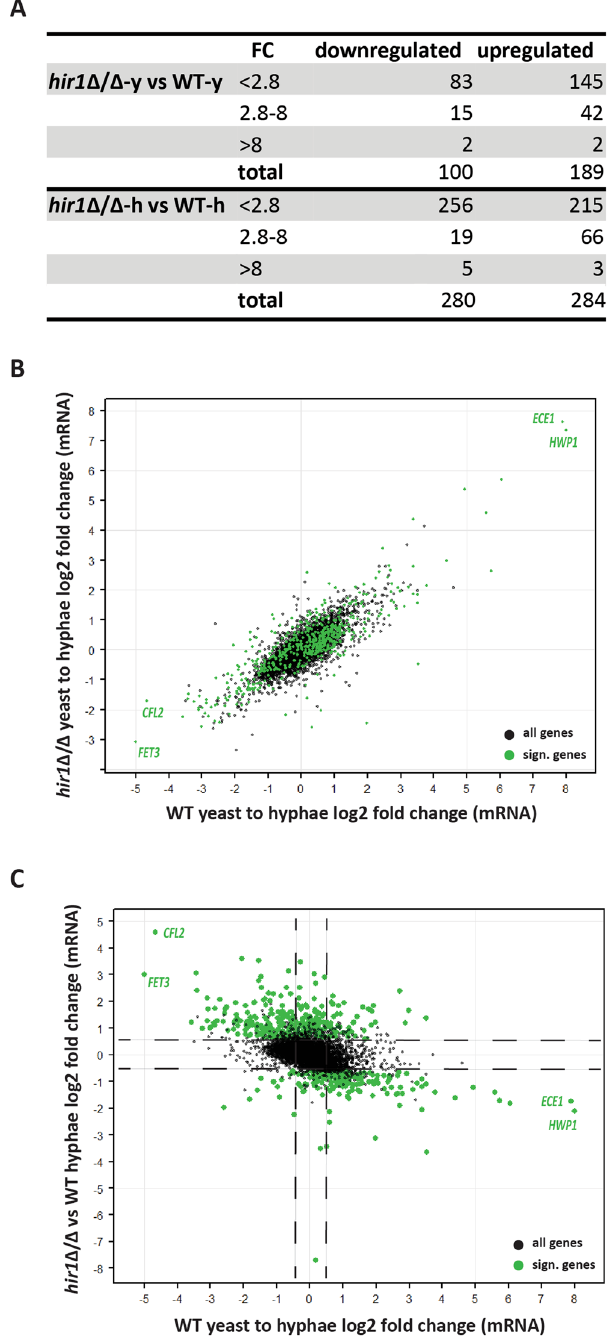
Figure 3. Hir1 affects the transcriptional amplitude during initiation of hyphal formation. ( A ) Absolute numbers of differentially expressed transcripts between WT and the hir1 Δ / Δ mutant during yeast (y) or hyphal (h) growth. Differentially expressed genes were defined by FDR < 0.05. FC, fold change. ( B ) The transcriptional profile of hir1 Δ / Δ cells showed high similarity to WT cells. log2-fold changes in RNA expression in WT cells during the yeast-to-hyphae transition (x-axis) were plotted against the log2-fold change in mRNA levels in hir1 Δ / Δ cells during the yeast-to-hyphae transition (y-axis). ( C ) Loss of HIR1 causes transcriptional deregulation during hyphal initiation. Each dot corresponds to one ORF. The log2-fold changes in RNA expression in WT cells during the yeast-to-hyphae transition (x-axis) were plotted against the log2-fold changes between HIR1 mutant and WT cells in response to hyphal-inducing conditions (y-axis). ( B , C ) Significantly differentially expressed genes in the hir1 Δ / Δ knock-out versus WT are depicted in green and were defined by an at least 1.5-fold change and FDR <